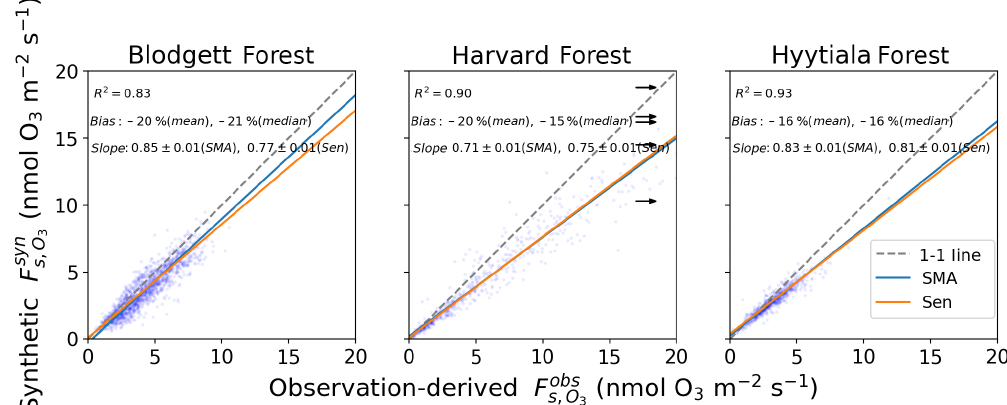
Figure 4. Synthetic and observation-derived daily daytime stomatal O 3 flux. See Sect. 2.1 for a definition of F syn explanation of the lines and inset